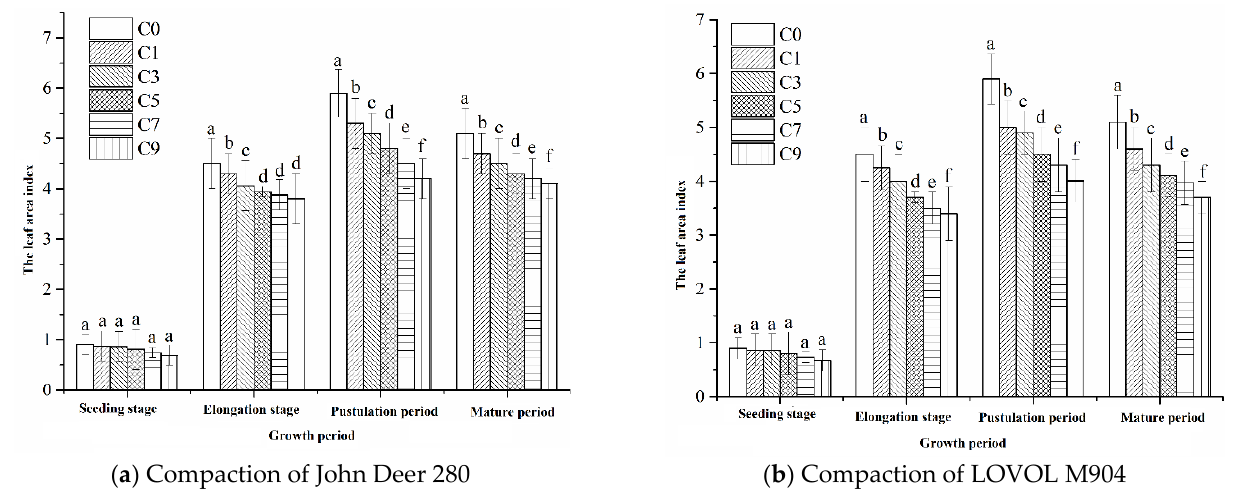
Figure 7. Effects of soil compaction on leaf area index (LAI) of maize during the critical growth period. Different lowercase letters indicate significant differences among treatments ( p < 0.05).